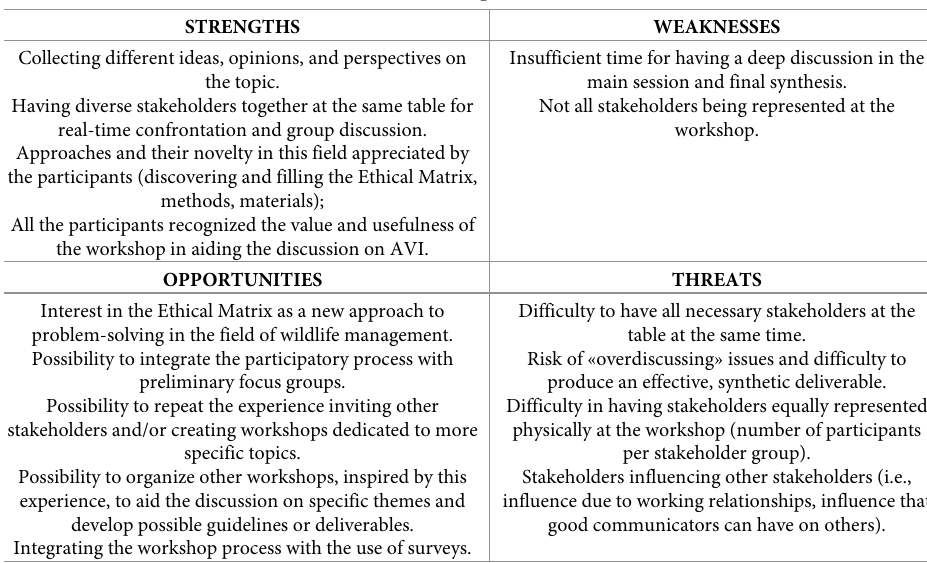
Table 3. Internal and external dimensions of the